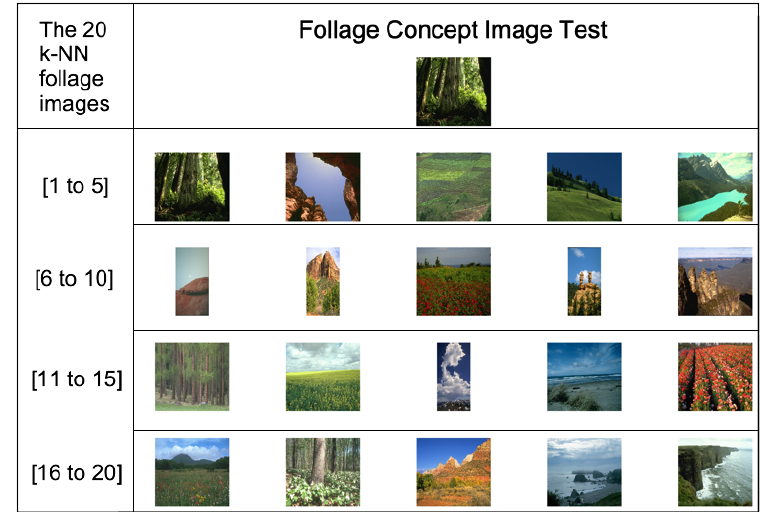
Figure 17. Retrieval results related to the concept of follage.